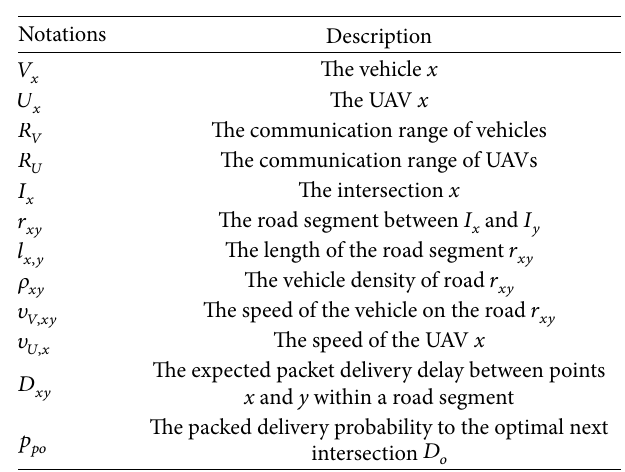
Table 1: Notations in UADD.